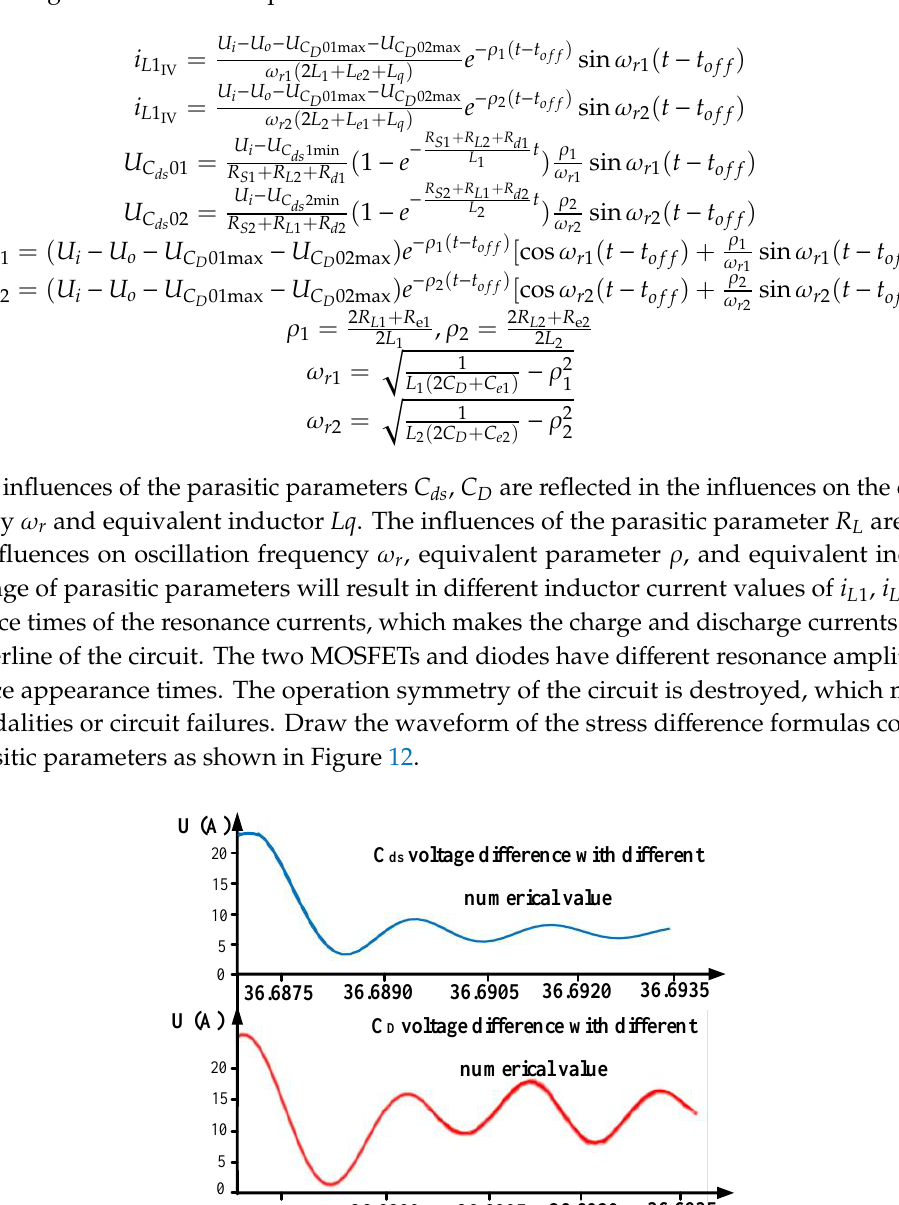
Figure 12. Waveforms of voltage stress with different parasitic parameter values.